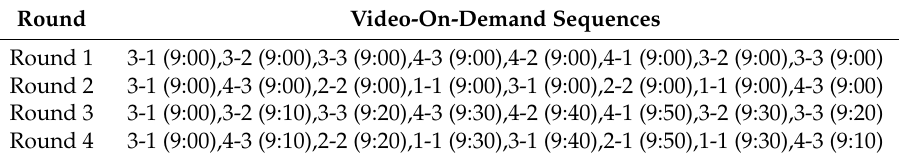
Figure 7. Average Playback Response Time. Table 6. Video-On-Demand Sequences.